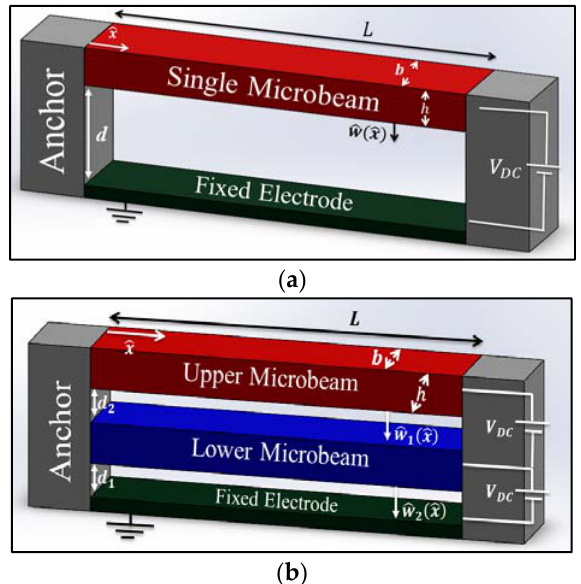
Figure 1. Schematic of a parallel ‐ plates based DC electrostatic actuator assuming: ( a ) a single ‐ microbeam; ( b ) a double ‐ microbeams configuration.